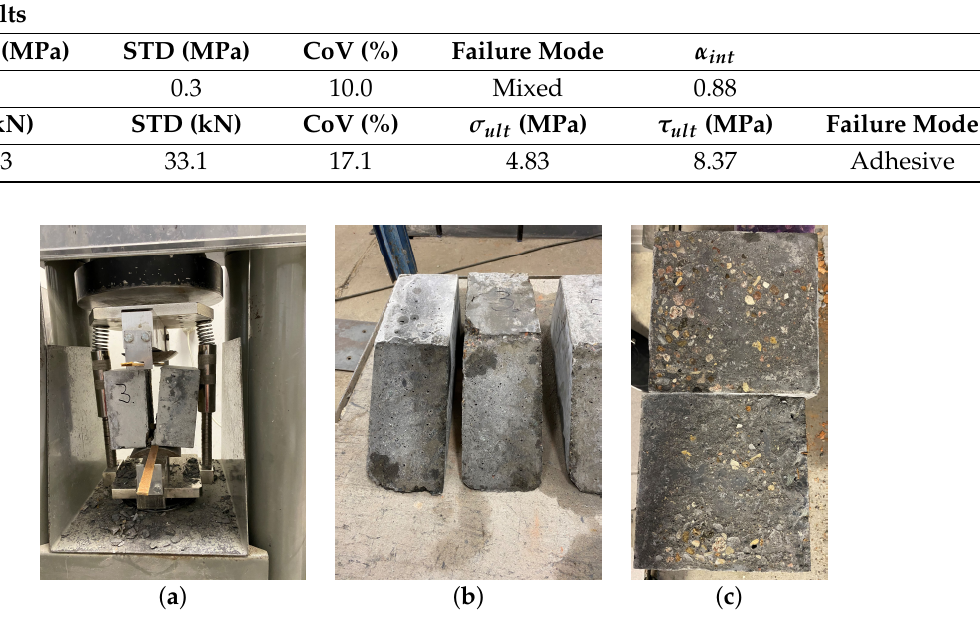
Figure 3. ( a ) The test stand after a splitting test. ( b ) Examples of surfaces after slant-shear tests. ( c ) Examples of surfaces after splitting tests.